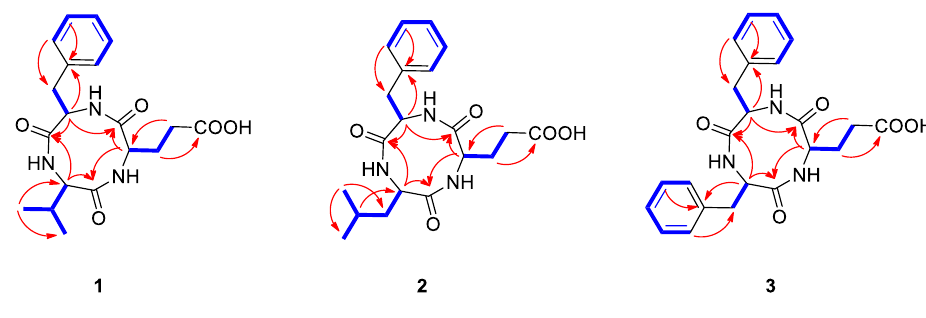
Figure 2. Key COSY ( ) and HMBC ( → ) correlations for compounds 1 – 3 .